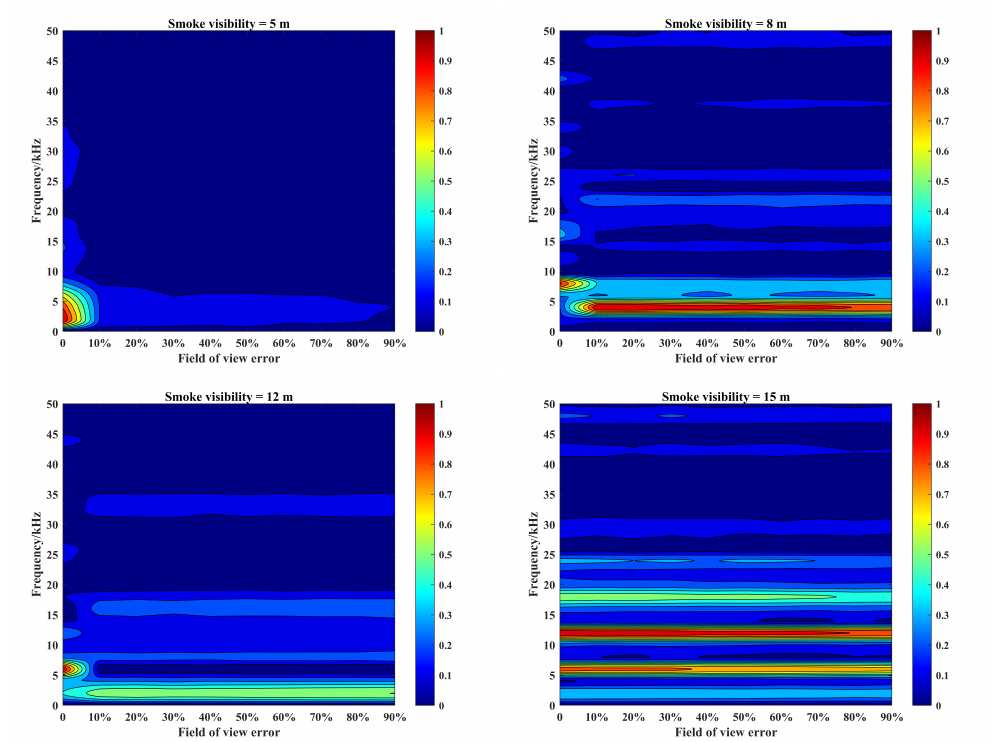
Figure 13. Amplitude–frequency characteristics of beat signals corresponding to divergence angle errors of laser source under different smoke visibility